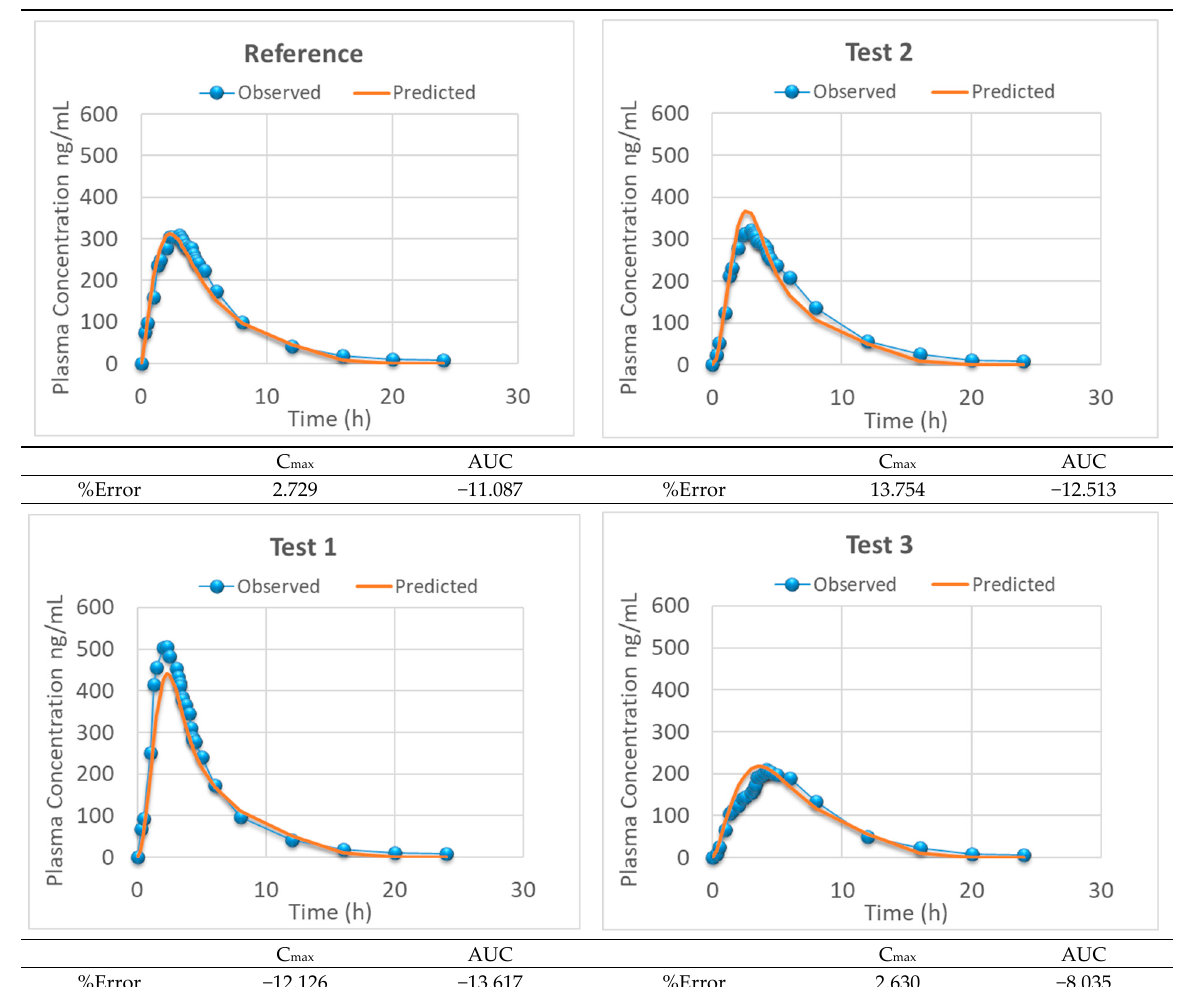
Figure 12. Experimental versus IVIVC-predicted plasma levels representing the two-step level-A IVIVC obtained with Reference, Test 1, and Test 3. Internal prediction errors and external prediction error for Test 2.